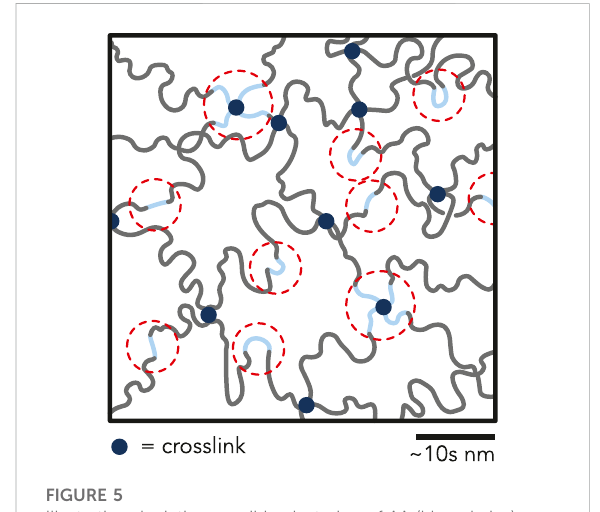
FIGURE 5 Illustration depicting possible clustering of AA (blue chains) within the P(AAm- co- AA)-12 hydrogel network. Due to low pH during polymerization, the reactivity ratio of acrylamide is less than unity, and the reactivity ratio of acrylic acid is greater than unity. Therefore, it is possible that AA-rich regions formed within the hydrogel network during polymerization leading to clusters of negatively charged domains, which may be partially responsible for superlubricity. Regions circled in red represent possible regions of counterion condensation and